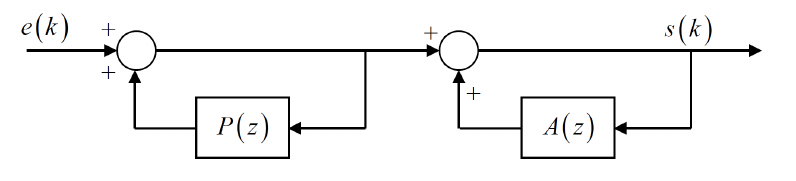
Figure 4. Synthesis